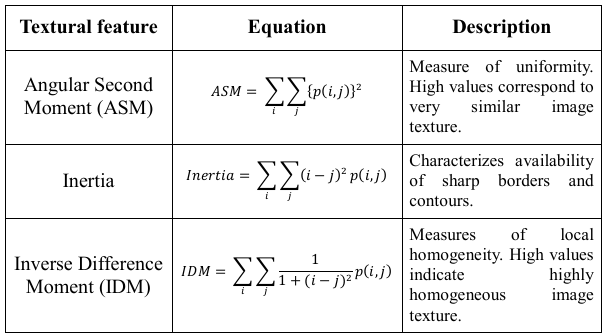
Table 1. Calculated textural